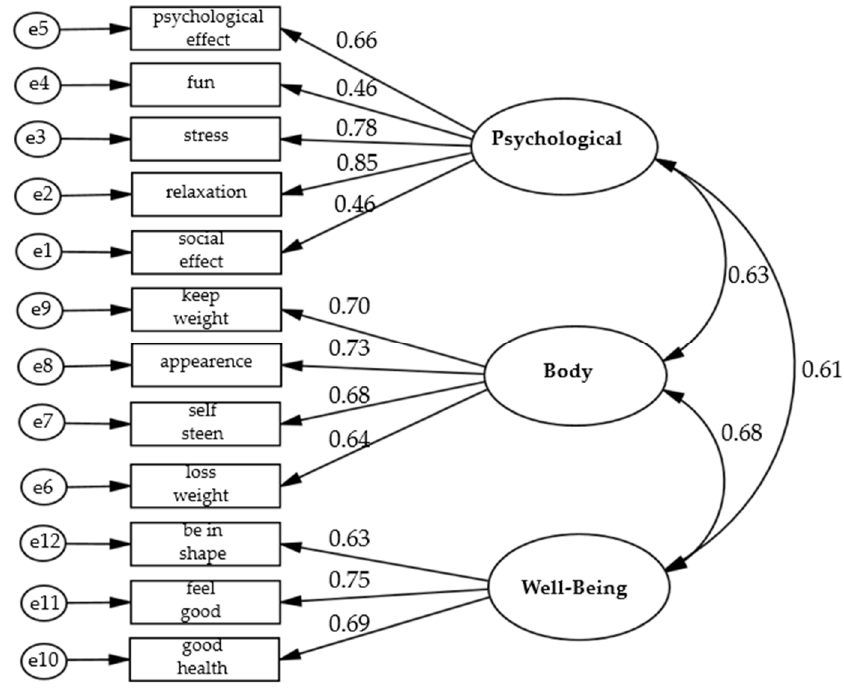
Figure 1. Factor analysis of questions about the motivations for practicing sport.